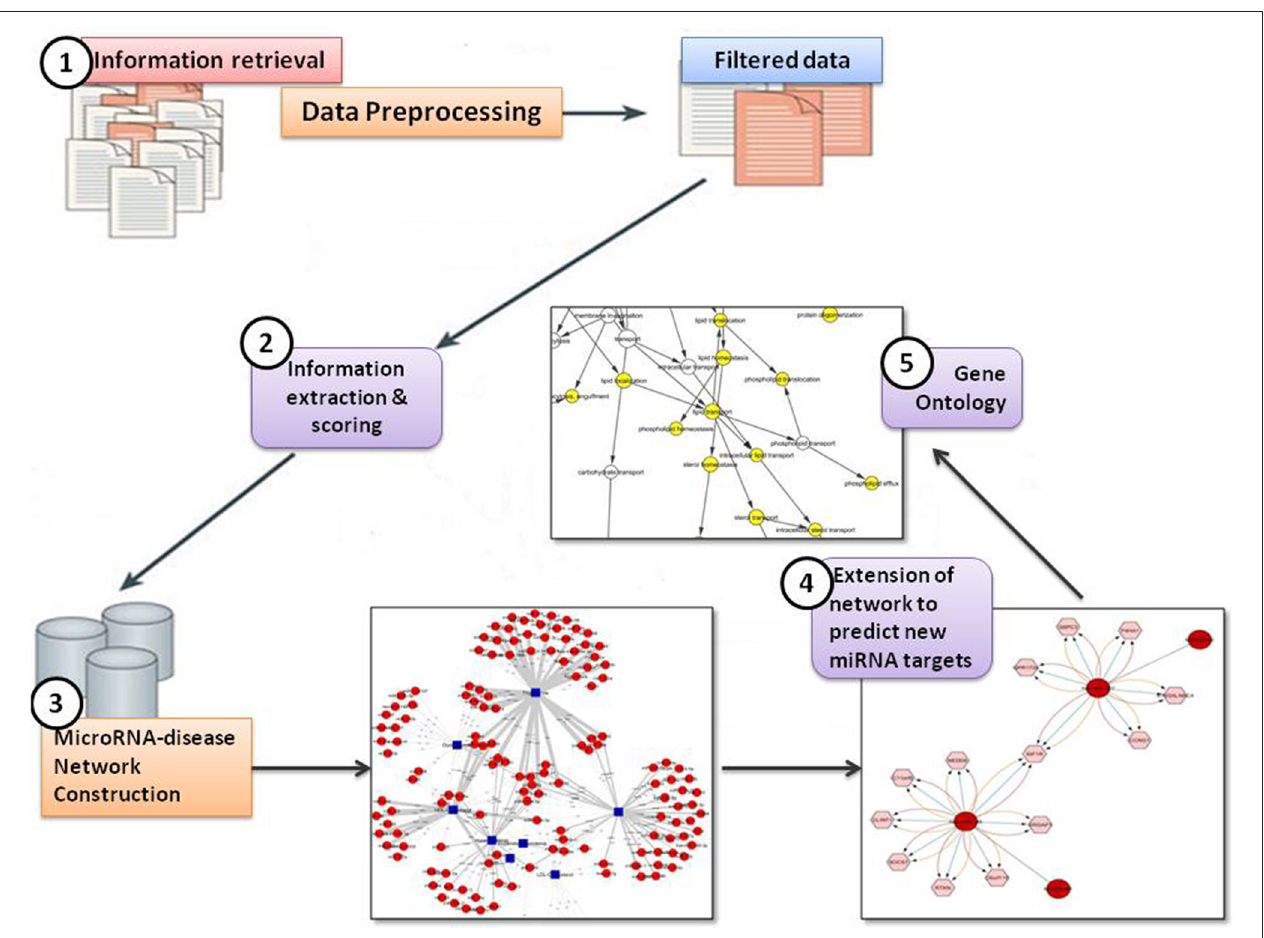
FIGURE 2 | Text-mining